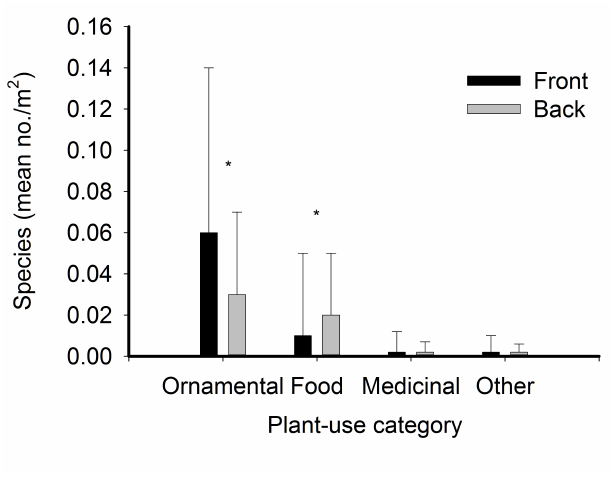
Fig. 8 . Paired t-tests evaluating differences between front yards and backyards in abundance of plants, by utilitarian roles. Error bars represent standard errors around the mean and (*) indicate significant tests at p values < 0.0001.